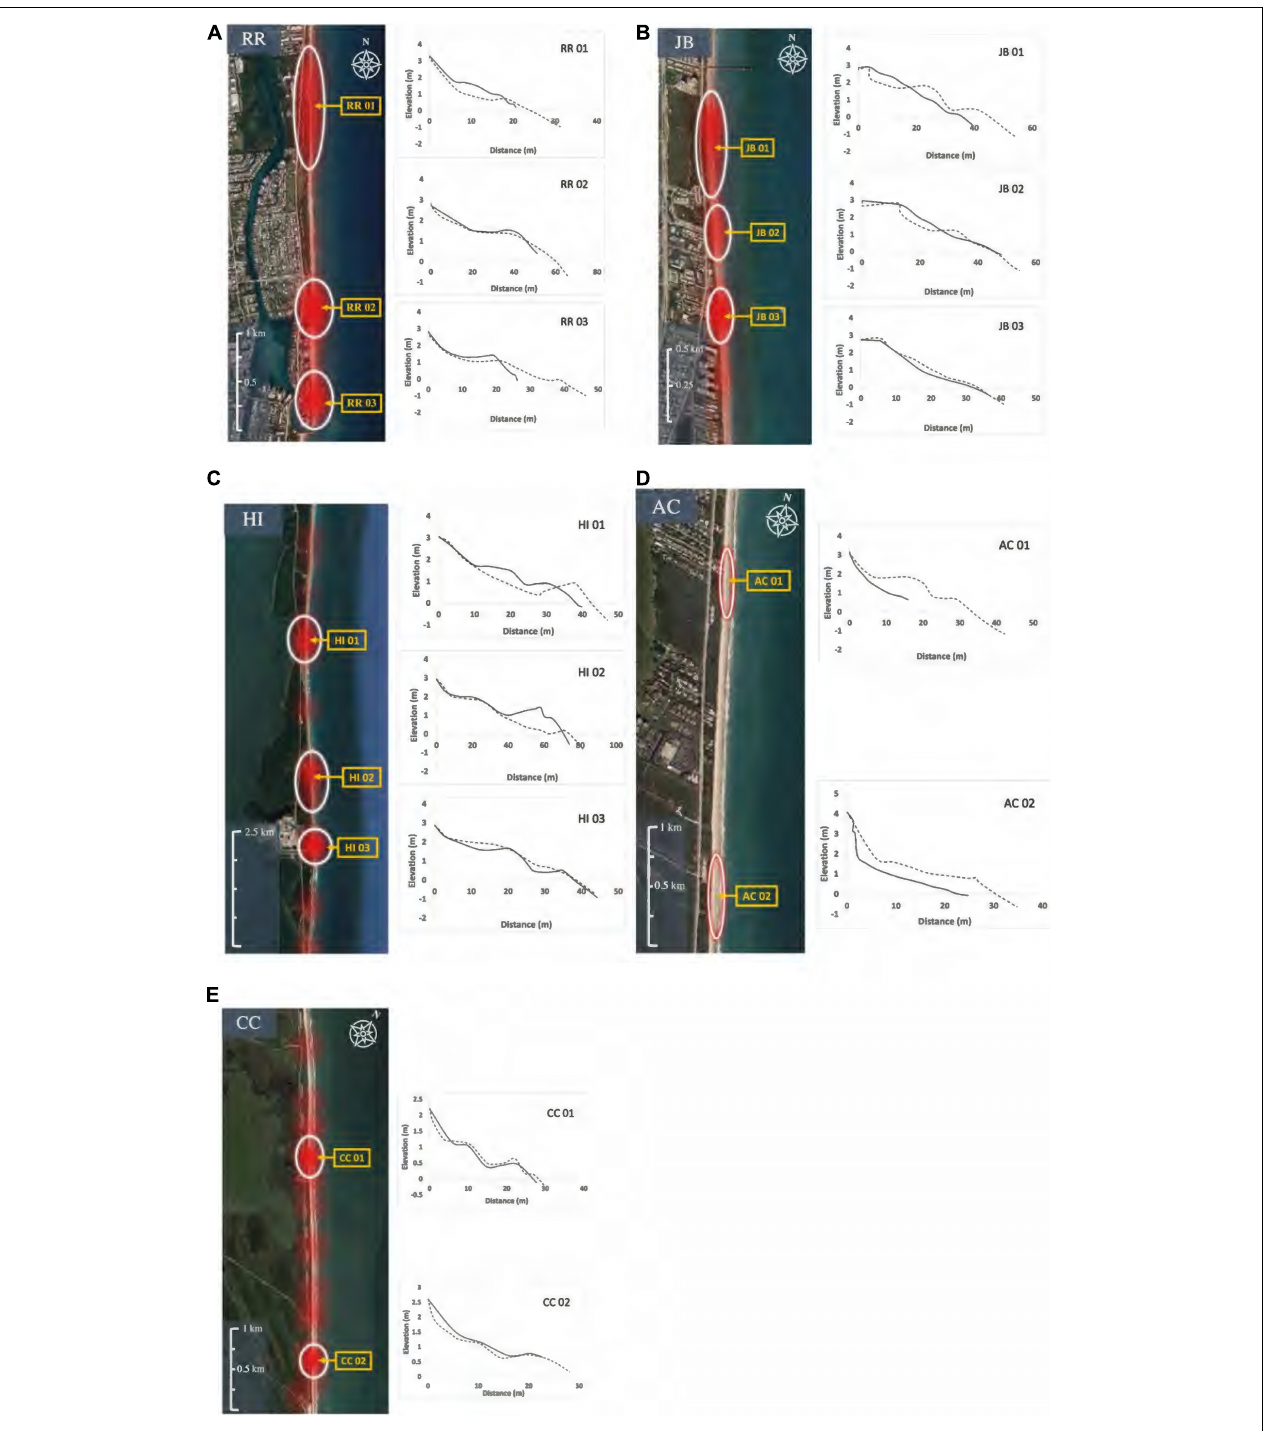
FIGURE 2 | (A–E) Heatmaps (QGIS 3.11) for highly successful loggerhead nesting areas. Hotspots are shown for Red Reef (RR), Juno Beach (JB), Hutchinson Island (HI), and Cape Canaveral (CC). Archie Carr National Wildlife Refuge (AC) hotspots were identified qualitatively through personal communication with long-term inventory staff. Loggerhead nests and sand were examined at two hotspots for each site. Transect locations for beach morphology measures are indicated with yellow arrows. Beach profiles corresponding with each transect are displayed to the right of each heatmap (June 2020 profiles—dashed line, September 2020 profile—solid